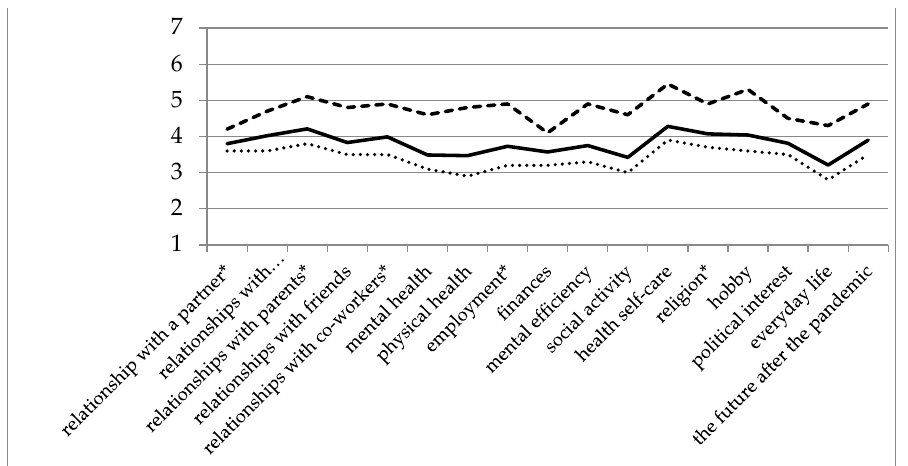
Figure 1. Sense of changes in various areas of life in the negative (NCH) and positive (PCH) sense of changes groups (solid line—the whole sample; dotted line—NCH group, and dashed line—PCH group); * scales not included in COVID-19 SLCHQ. Table 5. Correlations between the scores of the Impact of Event Scale: Revised (IES-R) and Sense of Life Changes Questionnaire (COVID-19 SLCHQ) in the groups with a negative (NCH) and positive (PCH) sense of